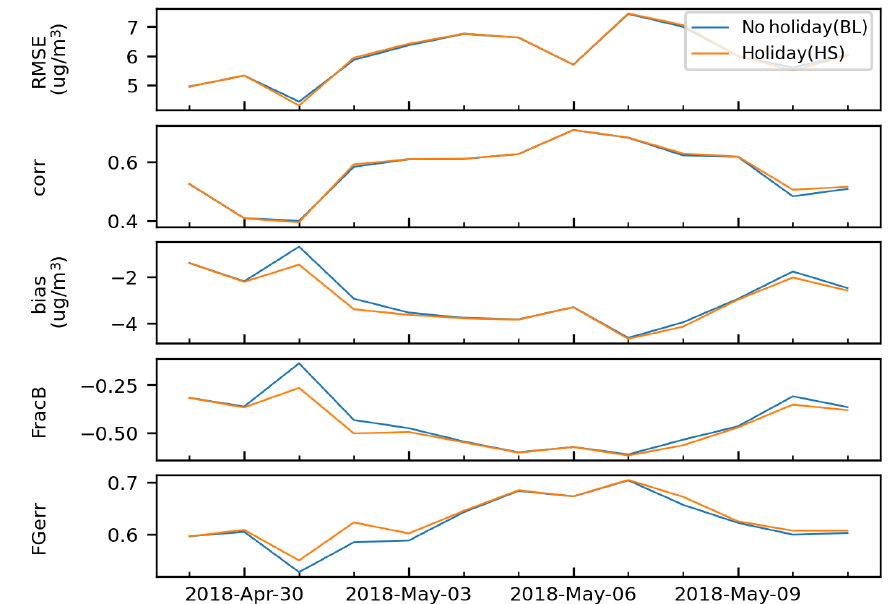
Figure 5. SILAM daily-mean spatial scores for May vacations (NO 2 , all of Europe).